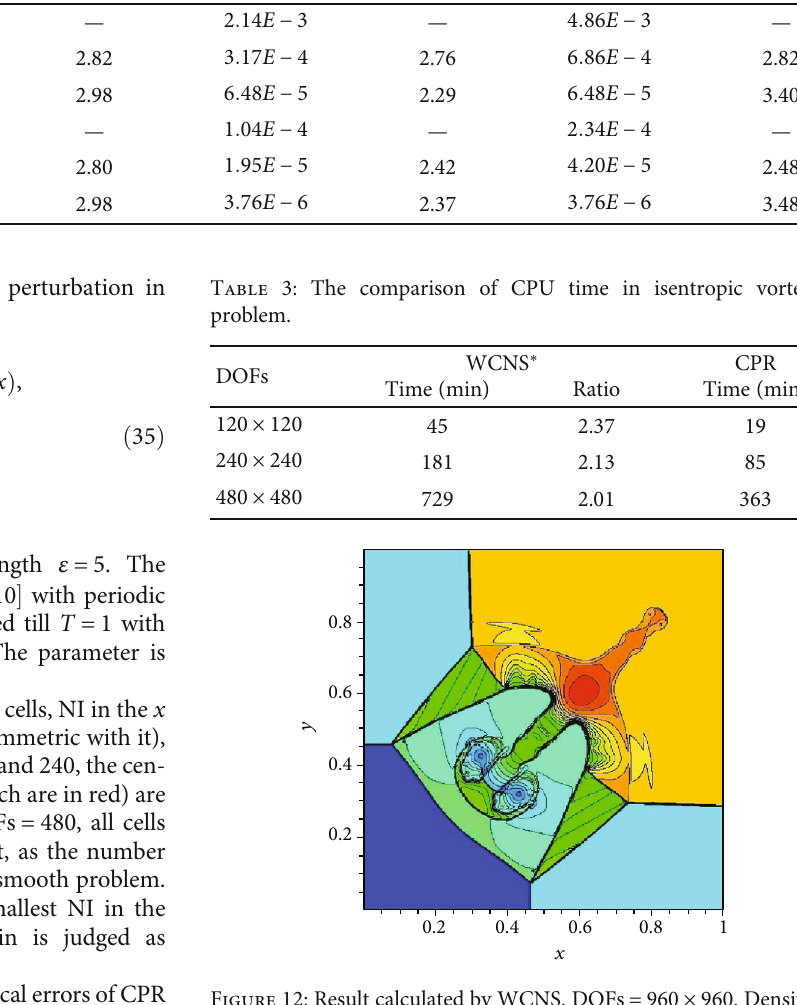
Table 2: Accuracy test of single scheme and hybrid WCNS-CPR scheme for the Euler equations.